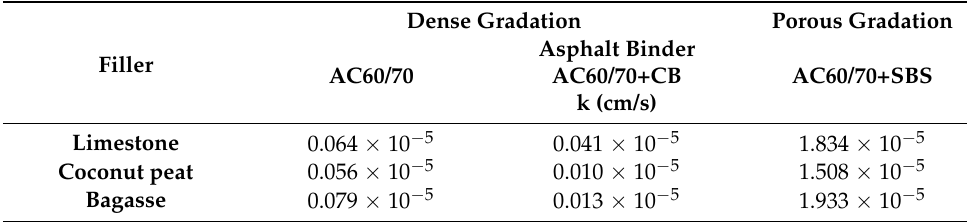
Table 5. The coefficient of permeability (k) of dense and porous gradation samples.